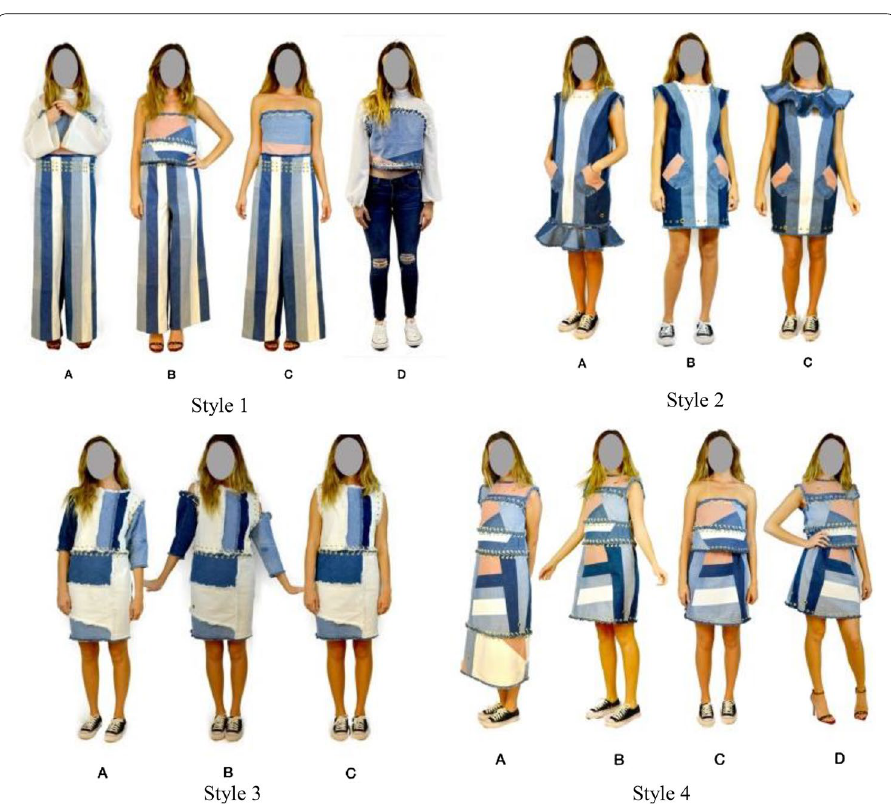
eyelets and cord were employed on the construction line of the garment, for example, waistline, neckline, and armhole. The researchers used a cord to connect each piece of the garment by passing the cotton cord over and through the eyelets. By re-lacing the cord, each style could be transformed and worn as